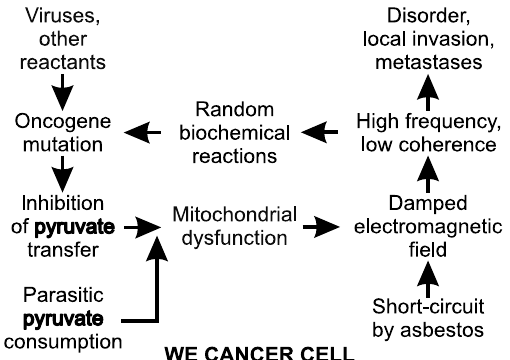
Figure 4. A schematic picture of physical pathological links in cancer development of the Warburg effect (differentiated) phenotype. Damping of the cellular electromagnetic field is the main functional link along the pathway of cancer development. The electromagnetic field can be damped by electrons released from the repolarized ordered water layers around dysfunctional mitochondria or by conducting fibers inside the cell, such as asbestos. The organization forces of electromagnetic nature in the cell are disturbed.